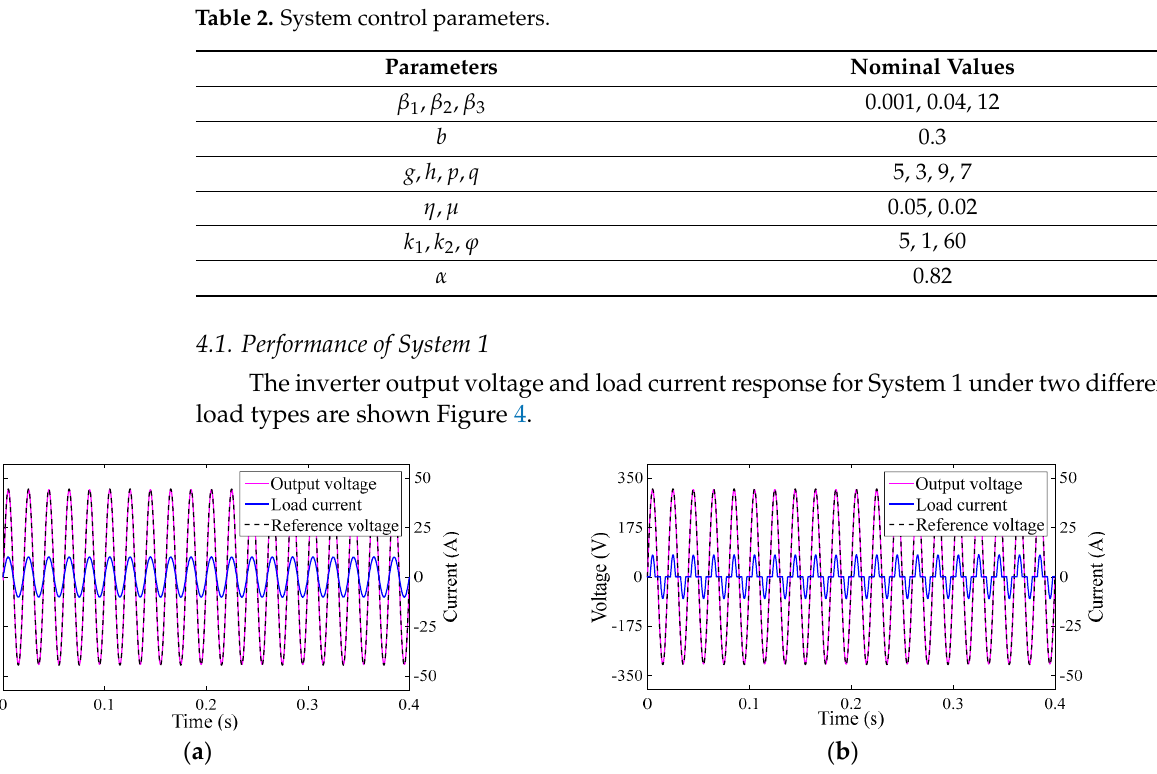
Figure 4. The output responses of System 1: ( a ) transient responses of System 1 in linear load and ( b ) transient responses of System 1 in nonlinear load. ( b ) transient responses of System 1 in nonlinear